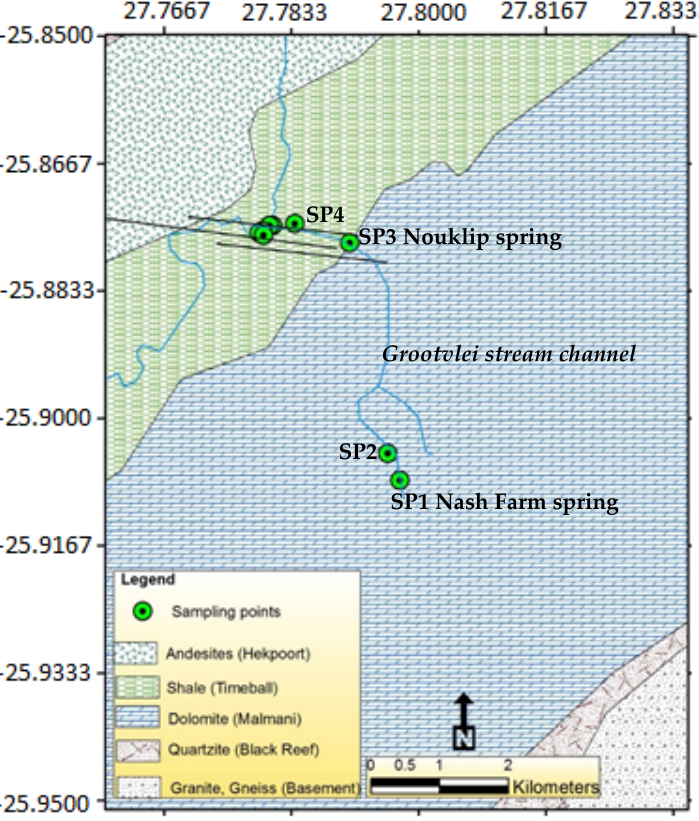
Figure 3. Geological map of the Malapa area showing some of the dolomitic springs (SP1, SP2, SP3 and SP4).